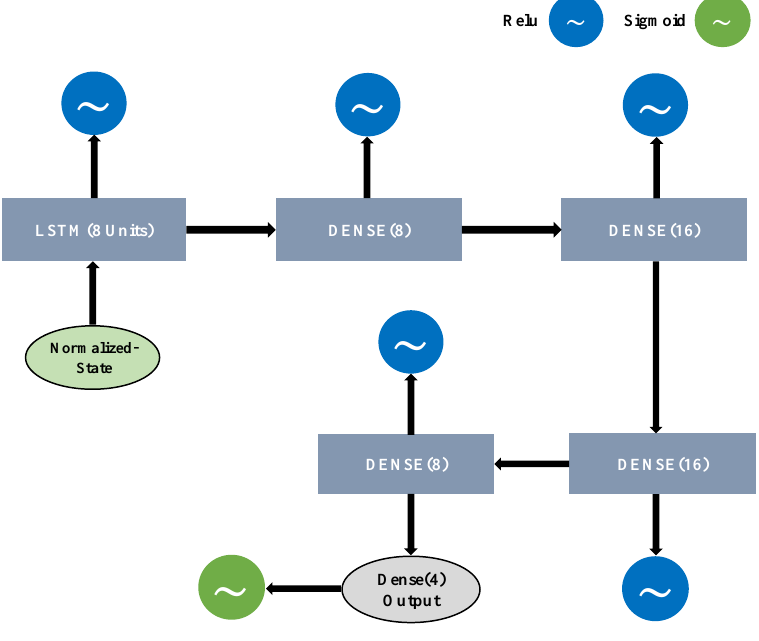
Figure 4. Proposed LSTM